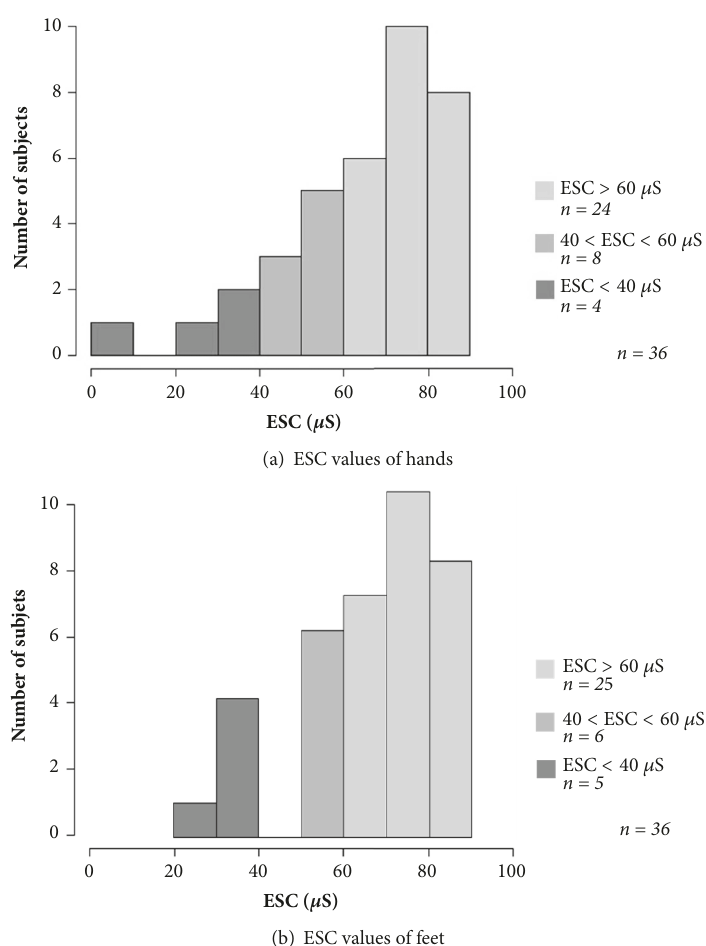
Figure 1: Distribution of the ESC values measured on hands (a) and feet (b) of oxaliplatin-treated patients (n = 36). High conductance values (ESC > 60 𝜇 S): no dysfunction of the sweat function. Intermediate conductance values (40-60 𝜇 S): first signs of a possible peripheral autonomicneuropathy. Low conductance values (ESC < 40 𝜇 S): dysfunction of the sweat function and advanced peripheral neuropathy. ESC: Electrochemical Skin Conductance. 𝜇 s: